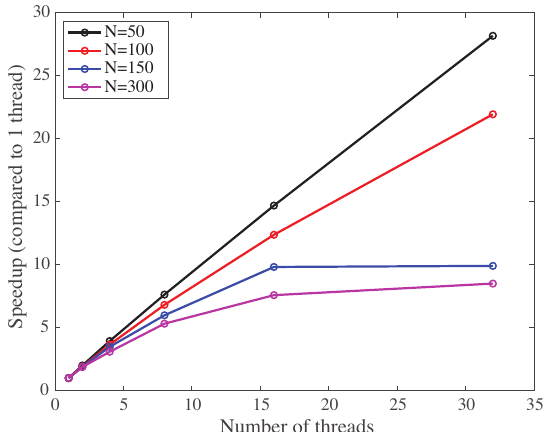
Figure 14. CPU time required to compute the Zernike moments of the gargoyle The speedup in clock time is plotted against the number of CPU or threads used by the parallel version of the approximate algorithm, for different maximum order (50, 100, 150, and 300). The speedup is obtained as an average over 5 independent